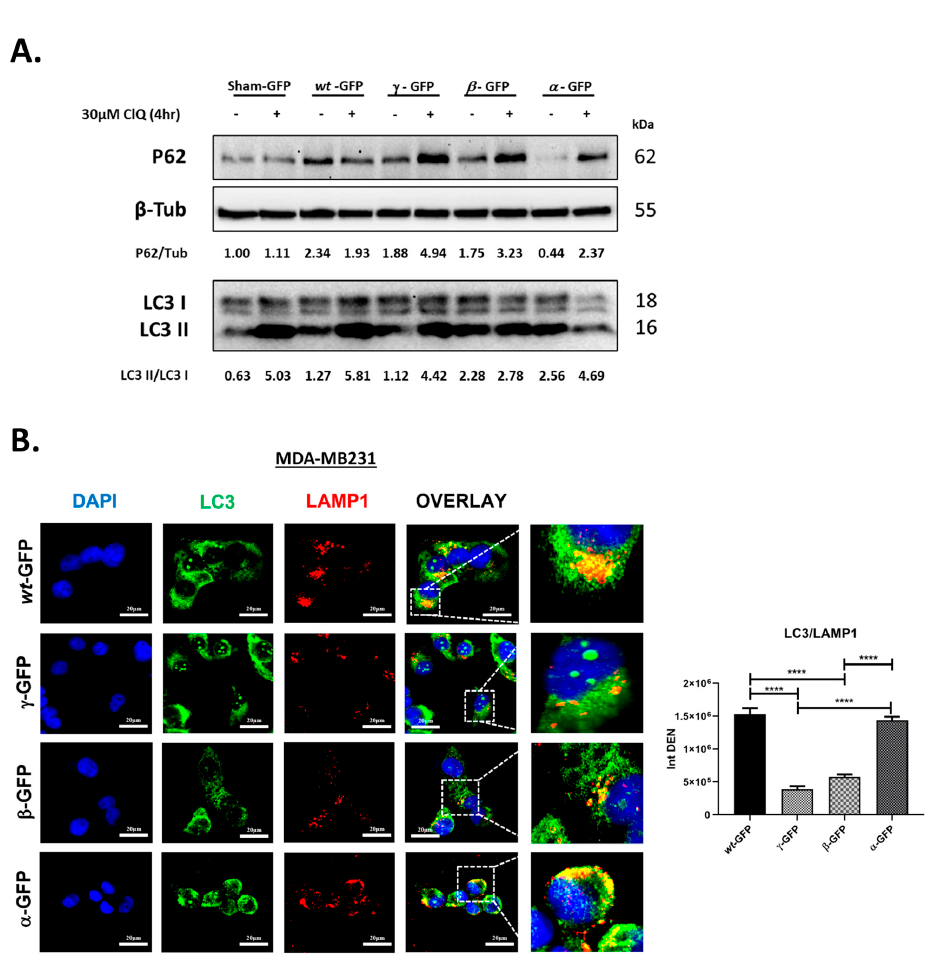
Figure 4. BECN1 isoforms have idiosyncratic effects on autophagy. ( A ) MDA-MB231 cells were transfected with pEGFP-N1 empty vector (Sham-GFP) or the vector carrying BECN1-wt-GFP (wt- GFP), BECN1- α -GFP( α -GFP), BECN1- β -GFP ( β -GFP), or BECN1- γ -GFP ( γ -GFP). After 48 h, cells were harvested and processed for immunoblotting with the indicated antibodies. Where indicated, cells were exposed to 30 µ M Clq for the last 4 h. Band intensities were determined by densitometric analysis and LC3-II/I or p62/tubulin ratios are shown. ( B ) MDA-MB231 cells plated on coverslips were transfected as in ( A ). After 48 h, cells were fixed, stained for LAMP1 (red) and LC3 (green), and imaged by fluorescence microscopy. Nuclei were stained with DAPI (blue). Cells shown in the panels were all positive for GFP fluorescence, indicating that all the cells were expressing the exogenous isoforms. Scale bars: 20 µ m. Histograms show the intensity densities of yellow signals (Int DEN), which result from close green and red fluorescence and are representative of the level of colocalization between LAMP and LC3. Asterisks indicate significantly different yellow signal intensities (**** p < 0.0001). Error bars,